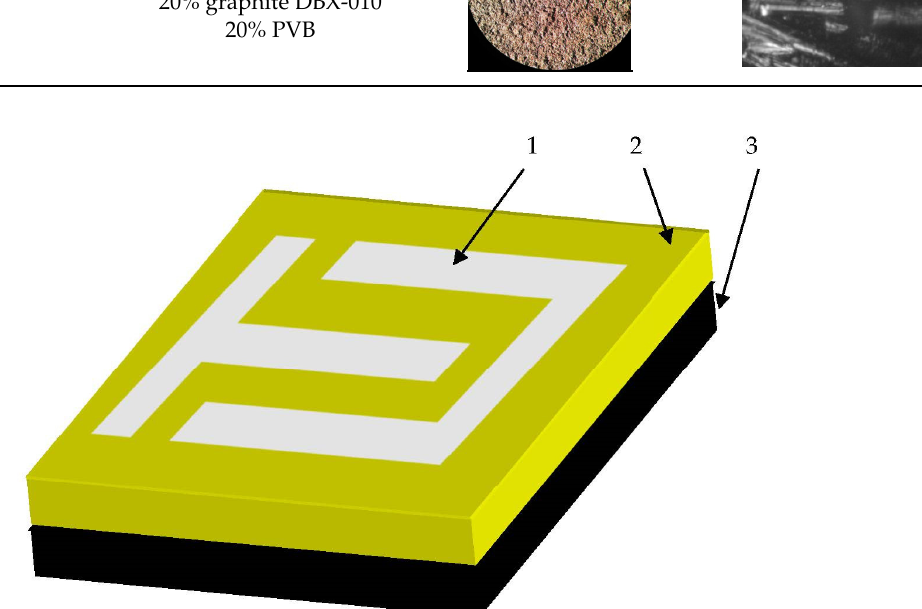
Figure 2. The sketch of the designed solar cell: (1) Ag contacts; (2) organic film; (3) carbon substrate.